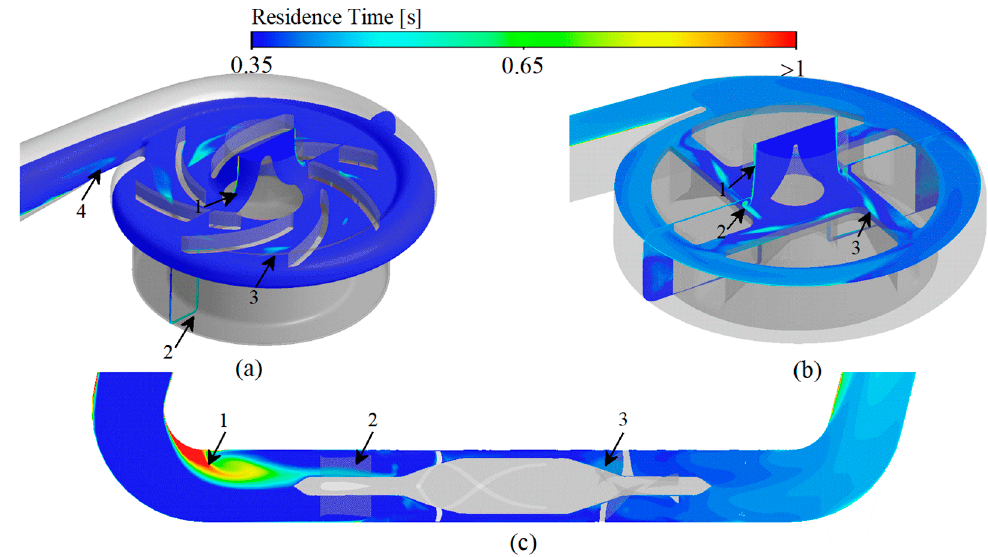
Figure 8. Residence time prediction of three studied VADs: ( a ) CH-VAD; ( b ) HVAD; ( c ) HMII.